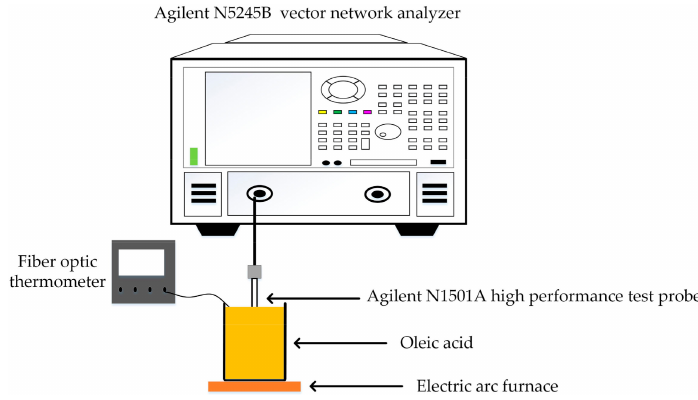
Figure 2. Complex permittivity measurement system. Table 2. The complex permittivity of oleic at different